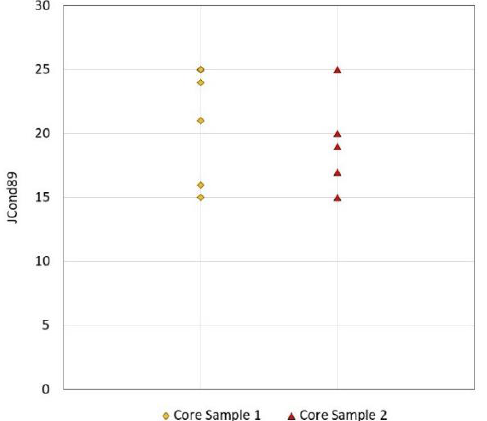
Figure 2. JCond 89 ratings determined by a group of experienced rock engineering professionals for two core samples (Core Sample 1 includes nine observations, Core Sample 2 includes eight obser- vations, with some of them overlapping).